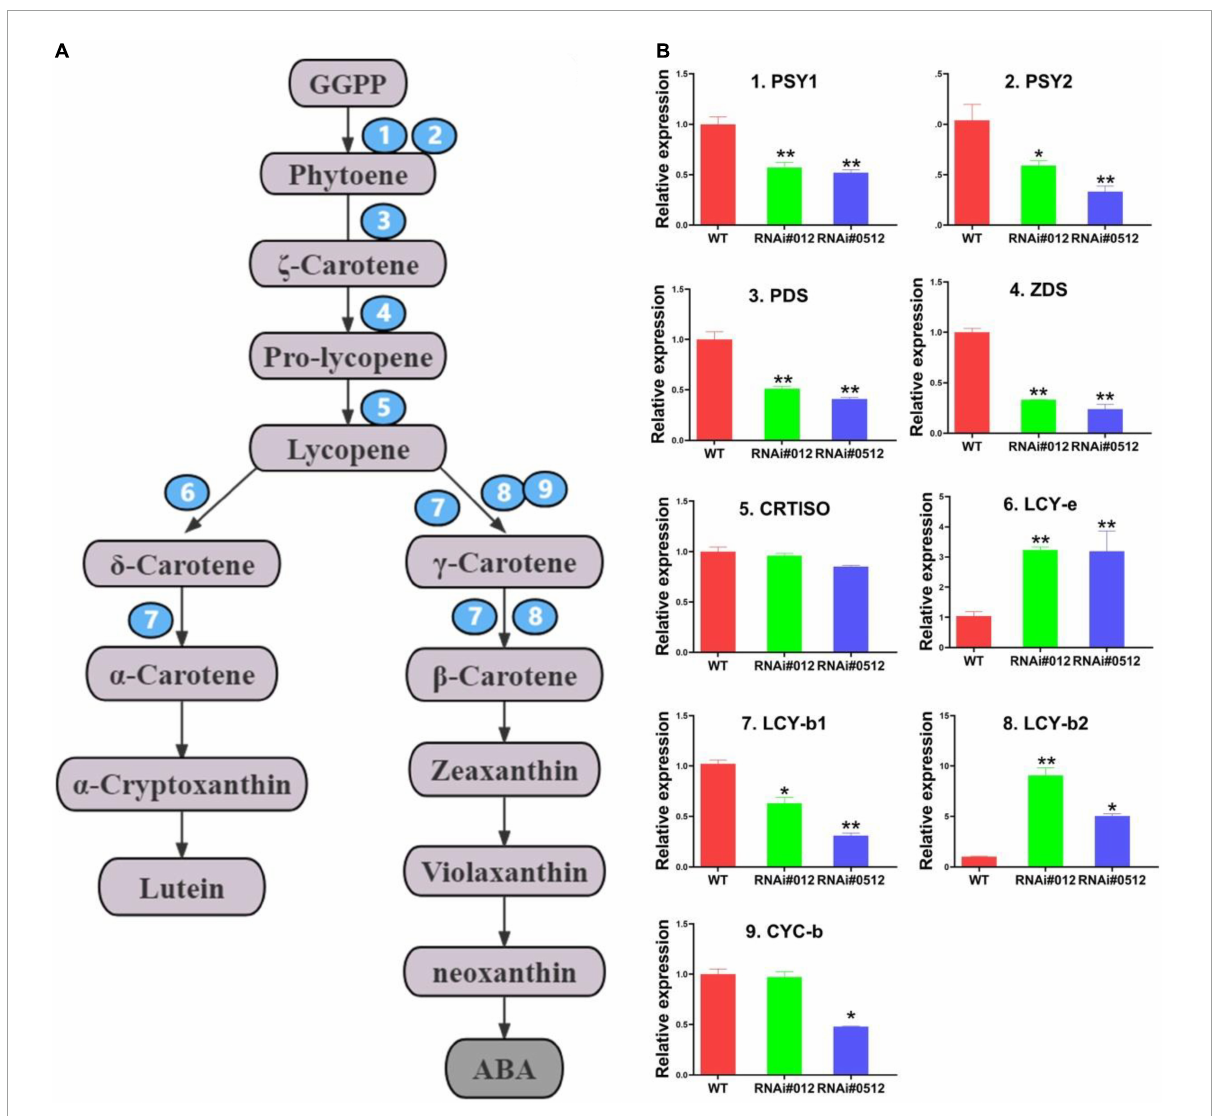
FIGURE2 Relative transcript levels of genes related to carotenoids metabolic pathway from WT, RNAi#012, and RNAi#0512 tomato fruits in Br + 3 stage. (A) Schematic representation of the carotenoid metabolic pathway. Carotene isomerase ; LCY-e . Abbreviations for other metabolites and enzymes have been described in the section “Introduction.” (B) Relative expression of core enzyme genes in carotenoids metabolic pathway in WT, RNAi#012, and RNAi#0512 tomatoes at Br + 3. Data contained three biological replicates, *representing P < 0.05 and **representing P < 0.01 ( t